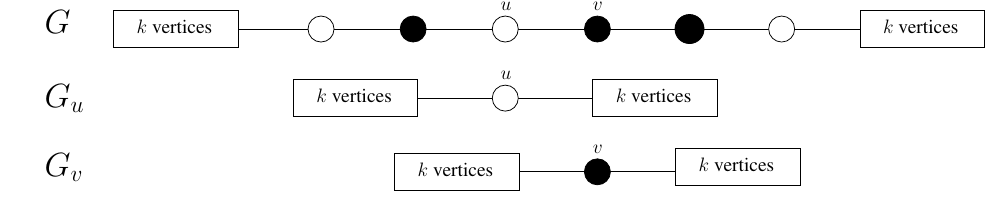
Figure 13 . A local algorithm A with locality distance k has to take the same decisions for the vertices u and v in G , G and G . The black vertices show a possible vertex cover computed by A . In order to 1 u v simplify the figure the rectangular boxes represent k vertices on the